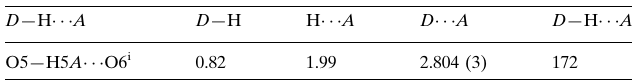
Hydrogen-bond geometry (A˚ , (cid:2)